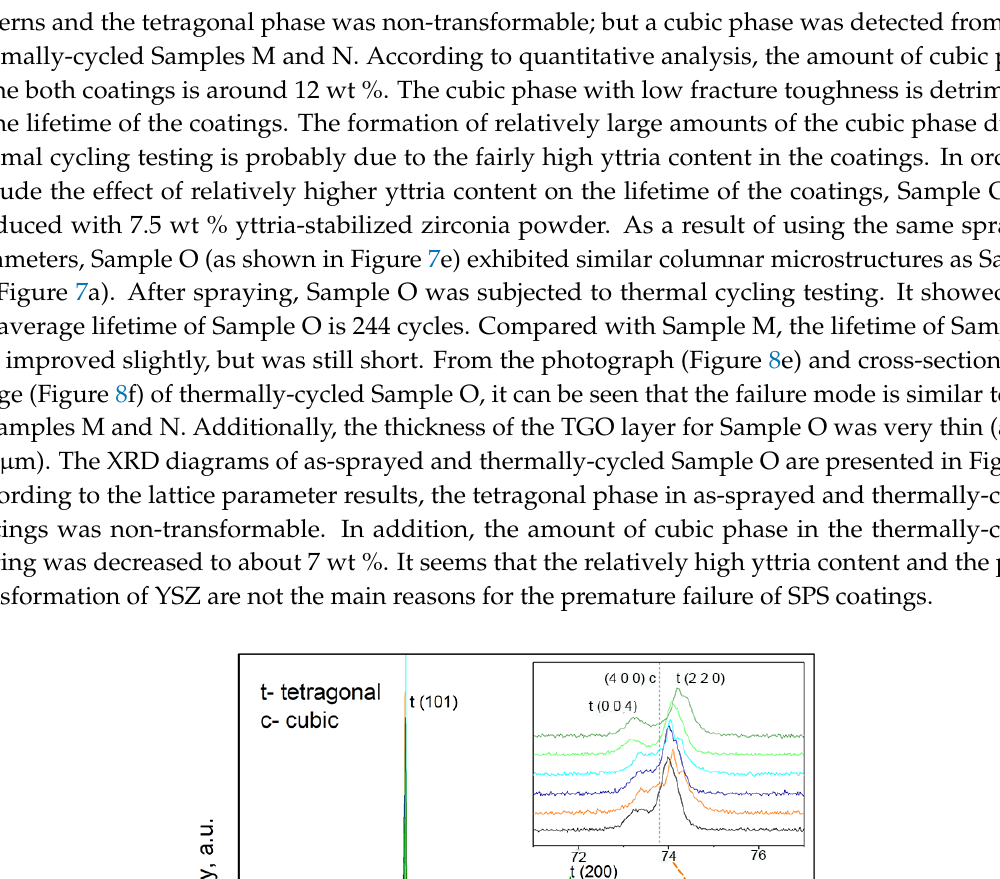
Table 3. Mechanical properties of as ‐ sprayed and thermally ‐ cycled Samples K, L, and